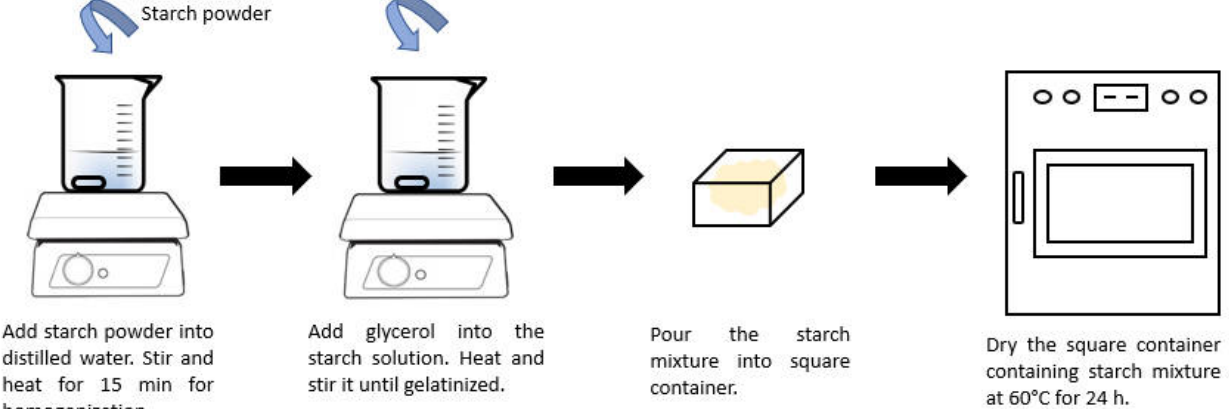
Figure 1. Experimental setup for bioplastic film